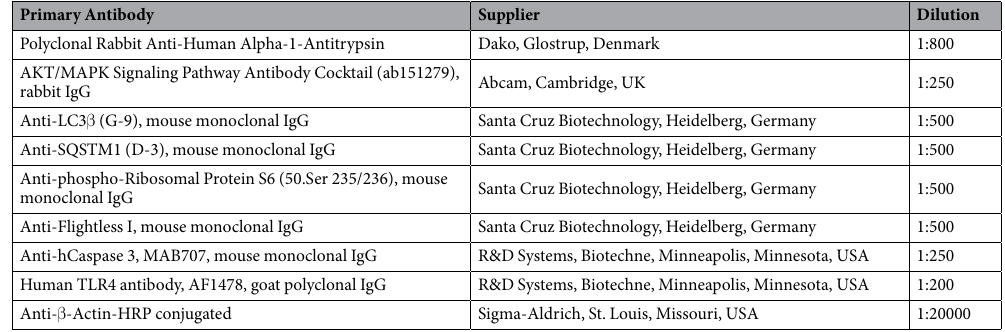
Table 1. Antibodies used for western